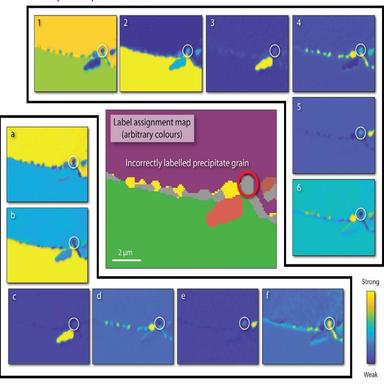
Second tile AOI (with arbitrary label colouring) of with EBSD weighting, w = 1. The mis-labelled precipitate grain (point C in is highlighted. PC scores and VARIMAX rotated RCC scores are presented. Principal components are ordered by their contribution to dataset variance, but RCCs are calculated to contribute equal variance. Score colour map is unnormalised between maps to show contrast.